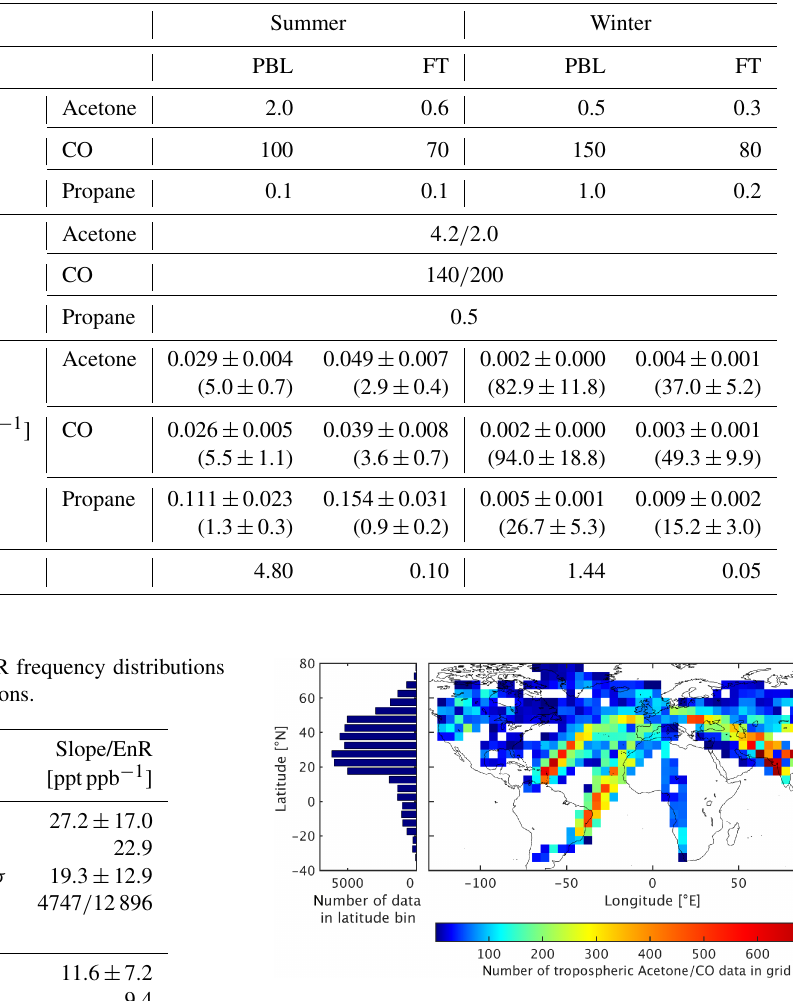
Figure 5. Latitudinal (left) and geographical distribution (right) of simultaneous tropospheric acetone and CO measurements in the time periods February 2006–December 2008 and March 2012–July 2015. Grid cells without data are left